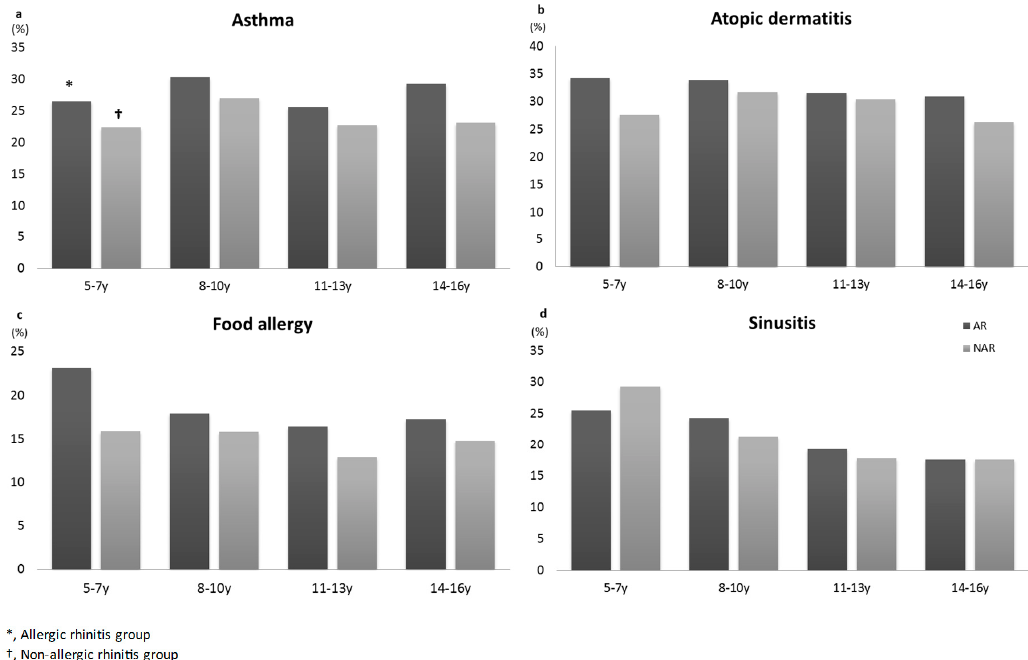
Figure 2. Comorbidities between children in different groups of AR and NAR. Abbreviations: AR, allergic rhinitis; NAR, non-allergic rhinitis.